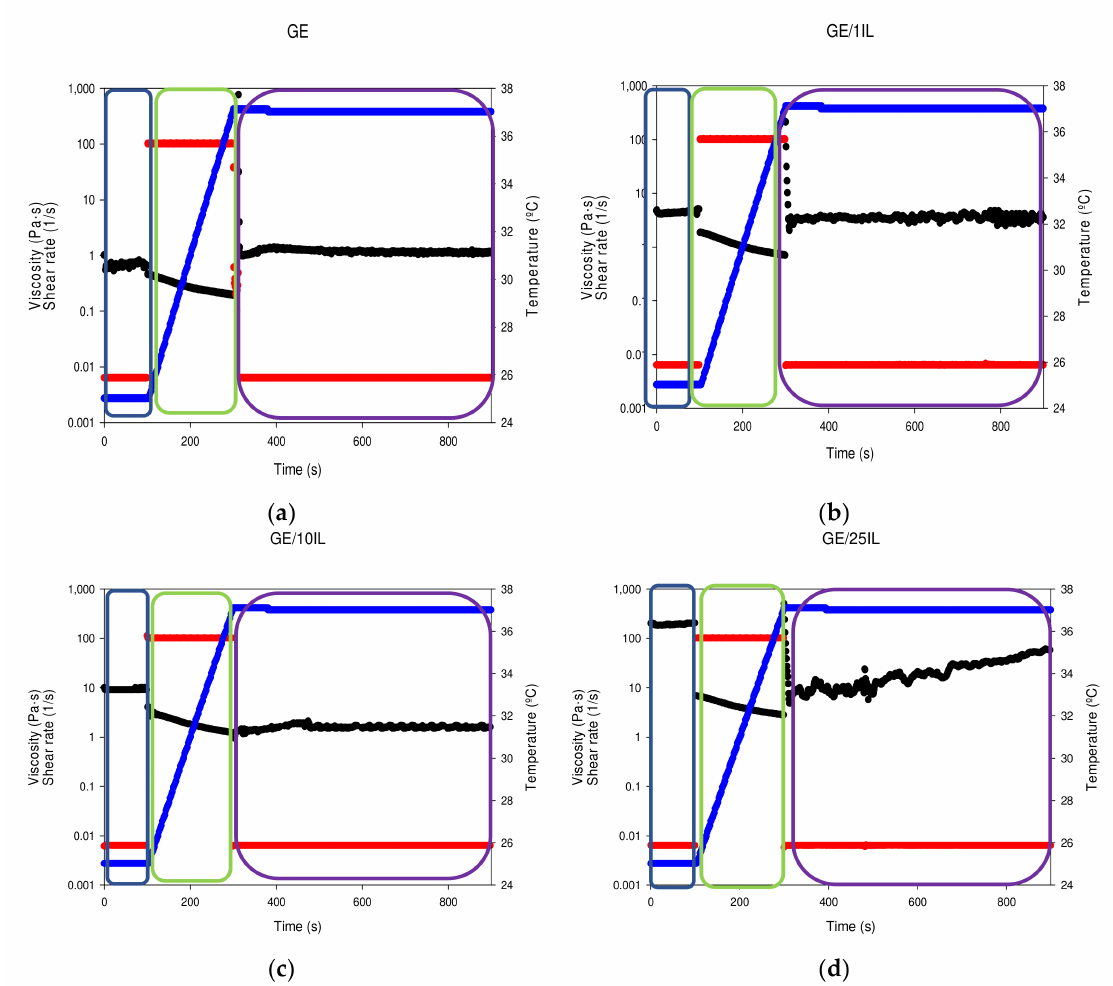
Figure 18. Syringe test results of gelatin hydrogel ( a ), GE; ( b ), GE/1IL; ( c ) GE10IL and; ( d ) GE/25IL. Viscosity (black colour), shear rate (red colour), temperature (blue colour).